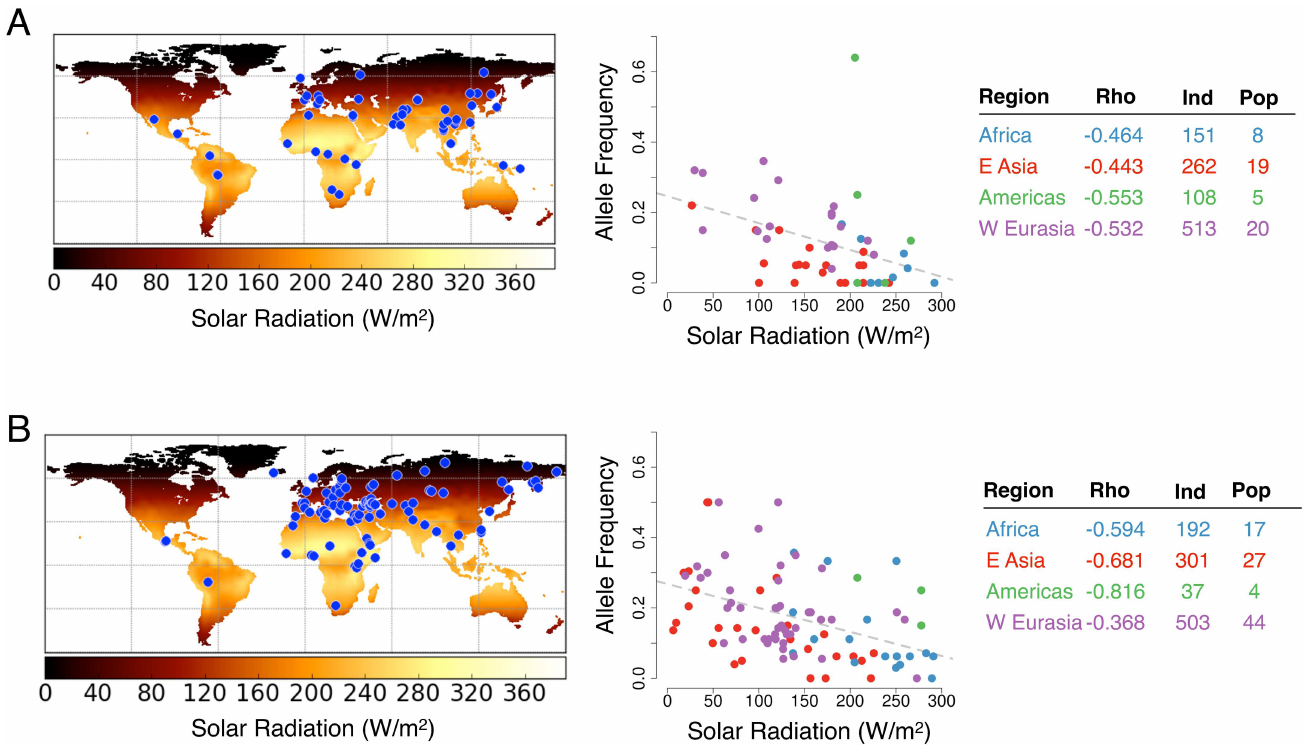
Fig 4. Testing se-eQTLs for signs of local adaptation. Environmental correlations with allele frequency in (A) HGDP populations and (B) Lazaridis et al [62] populations. Left panels: Heatmap of the environmental variables used in the study. Units are Watts per meter squared. Populations are marked with blue circles. Note that three of the American populationsfrom Lazaridis et al . (Mixe, Mixtec, and Zapotec) [62] are marked in the same geographic location. Right panels: Radiationlevel vs allele frequency of the population for the RASSF9 se-eQTL (rs11117173) with the color indicating the regionalsubgroup. For each regionalsubgroup, the Spearmancorrelation(Rho), the number of individuals(Ind), and the number of populations (Pop) are providedin the table.